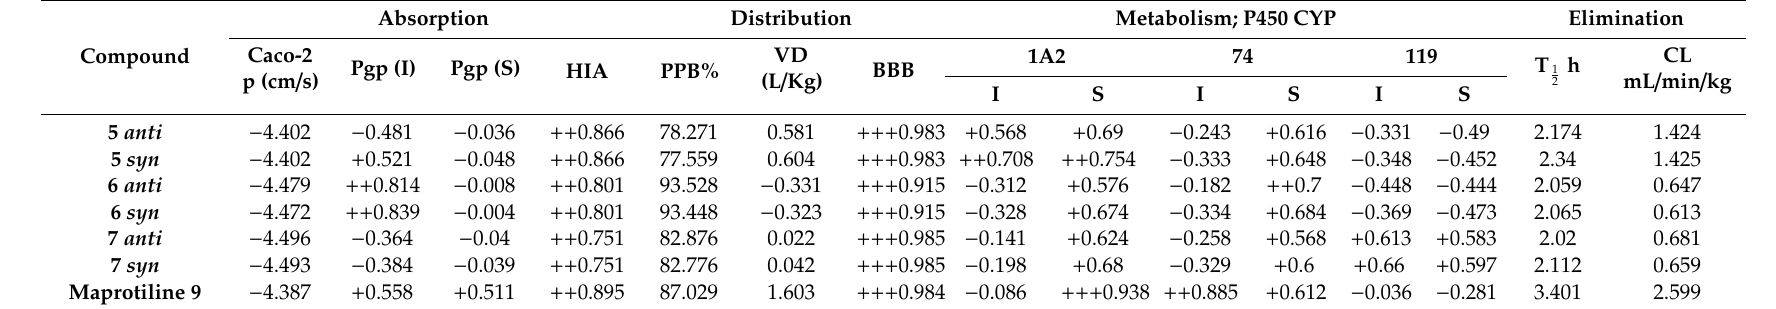
Table 7. ADME properties of the compounds (5–7) anti , (5–7) syn, and maprotiline 9 using ADMETlab